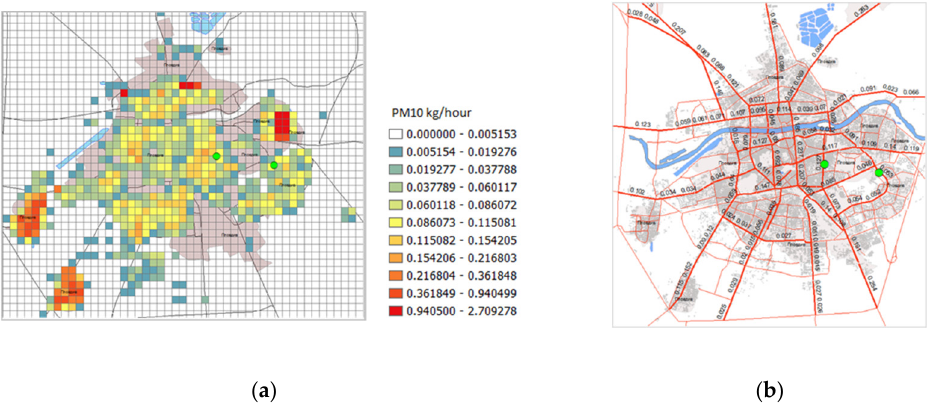
Figure 3. Emissions of PM 10 (kg.h − 1 ) for the city of Plovdiv originating from: ( a ) household heating; ( b ) traffic at different road segments. The green dots indicate the two AQ stations in the city.